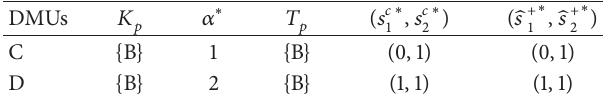
Table 4: Result of Part (b) of the proposed algorithm in Example 2. Table 5: Data set in Example